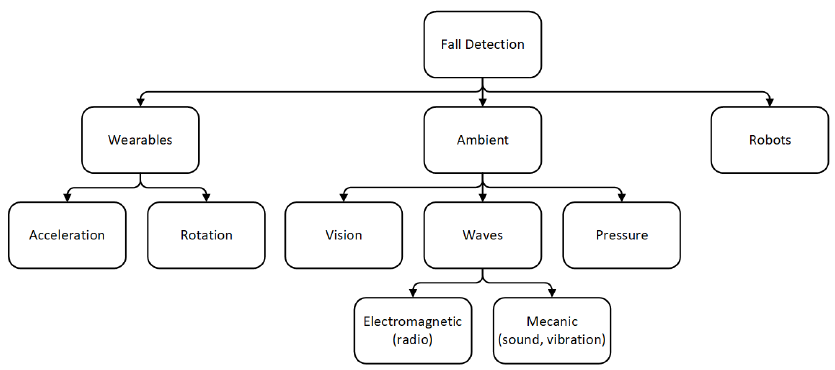
Figure 1. Classification of Fall Detection System approaches. Table 1. Reviewed studies that used wearable sensors for fall detection (including acronyms at the end of the table). Research Authors